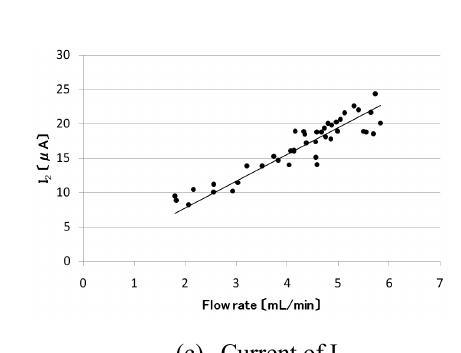
Fig. 13 Currents as a function of flow